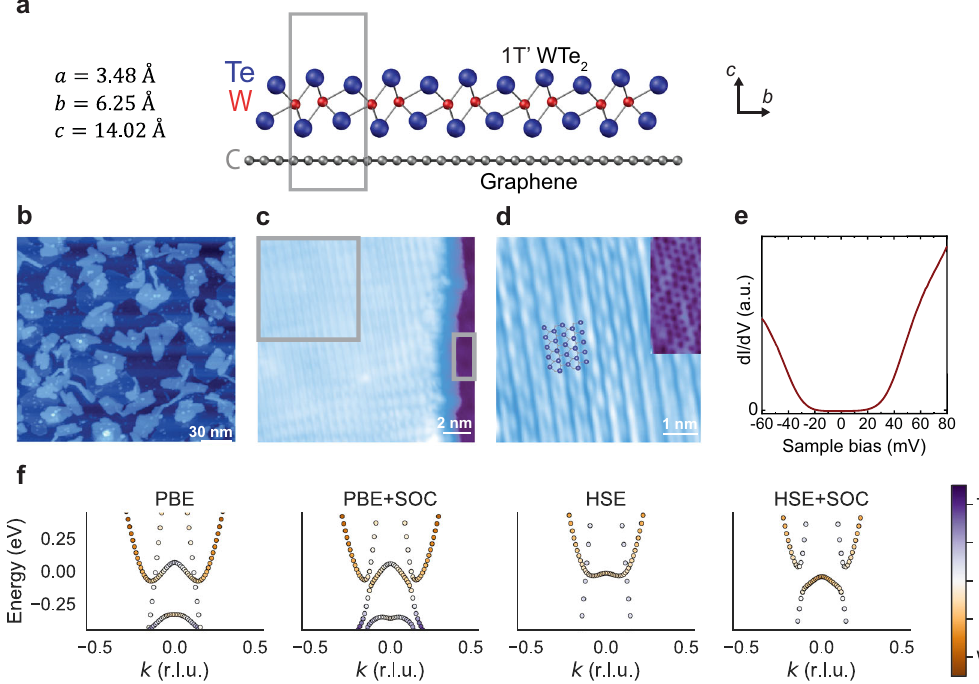
Fig. 1 Crystal structure and electronic structure of ML-WTe 2 fi lms. a Crystal structure of monolayer 1 T ′ -WTe 2 . b A typical large-scale topography of MBE-grown monolayer WTe 2 on graphene on SiC. c , d Zoomed-in topographies of monolayer islands showing characteristic Te stripes with atomic resolution. The graphene substrate can be identi fi ed to the right of the island in ( c ). e STS spectrum on the interior of one of the islands of the monolayer showing a gap of ~40 meV. f Calculated band structures of ML-WTe 2 (naive and DFT-calculated including spin- orbit coupling with PBE and HSE potentials